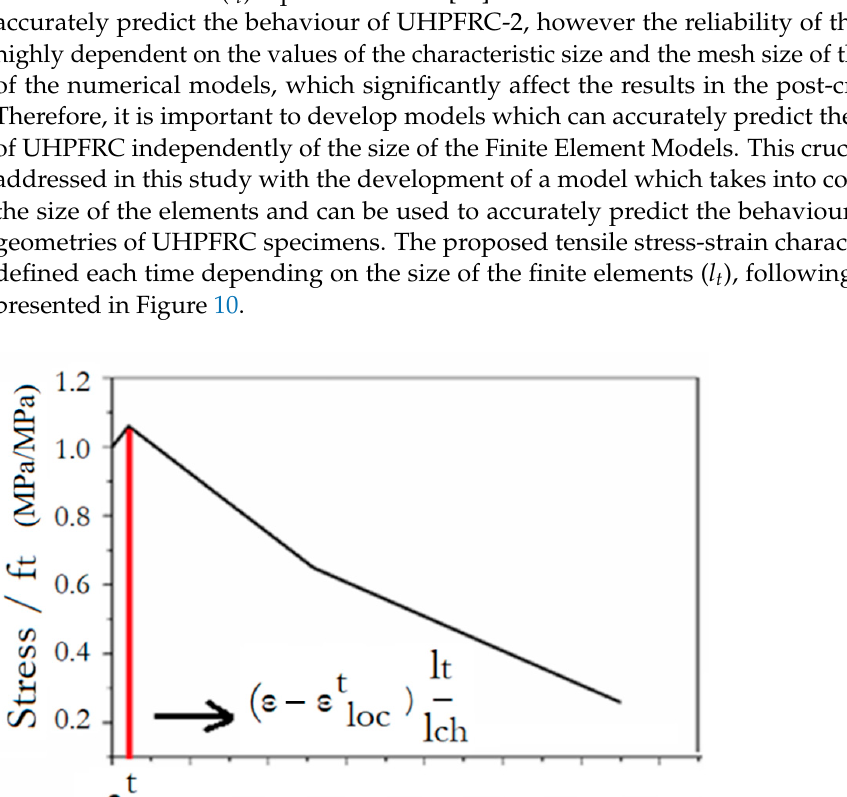
Figure 11. Numerical models for UHPFRC-1 prisms ( a ) 25 × 90 × 360 mm and ( b ) 100 × 100 × 500 mm.